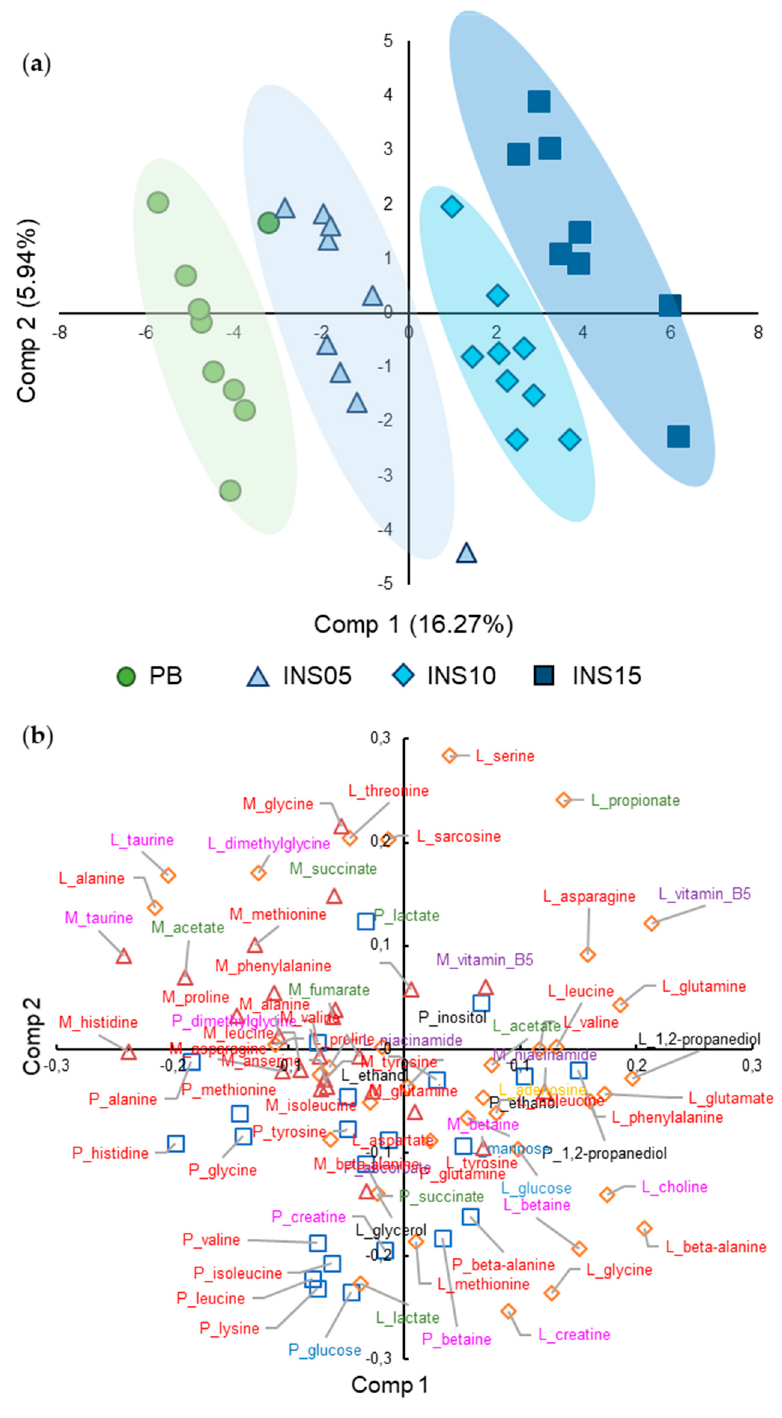
Figure 2. OSC-PLS-DA of 84 metabolites measured in fish plasma, liver or muscle, for fish fed PB, INS05, INS10 or INS15 diet for 84 days. Q 2 = 0.90, R 2 Y = 90.13%, P = 0.036. ( a ) Scores plot of individuals on first two components. Green circles, PB; light-blue triangles, INS05; blue diamond, INS10; dark-blue squares, INS15 diet. ( b ) Loading plots on first two components. Squares, plasma metabolites (P_); triangles, muscle metabolites (M_); diamonds, liver metabolites (L_). All metabolites with a loading value below -0.06 or above 0.06 on one of the first two components are annotated and colored according to their compound family: red, amino acids or dipeptides; green, organic acids; blue, sugars; black, alcohols or cyclitols; pink, amines or N-containing compounds; yellow, nucleobases or nucleosides; purple, vitamins.